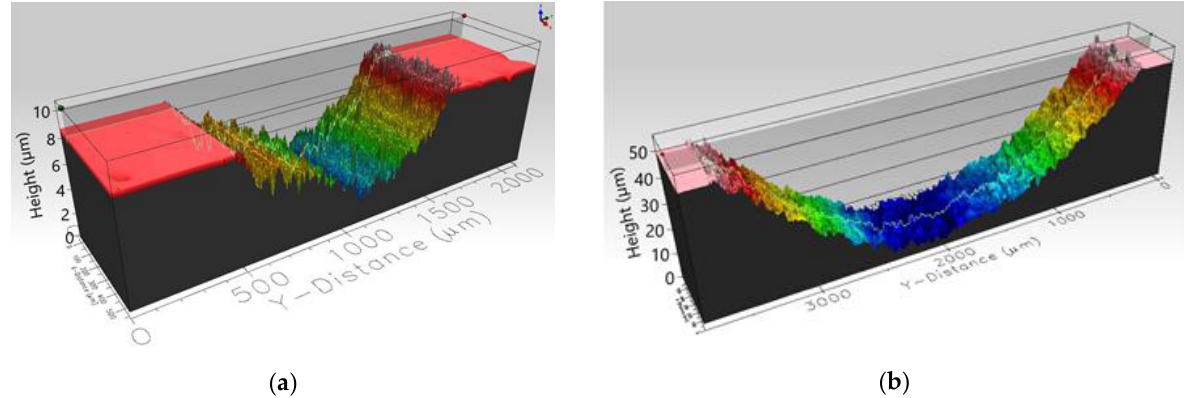
Figure 2. Profilometer characteristics of the worn ATZ sample surface used for volumetric characteristics of the mass loss during the tribological test; collected at 20 °C ( a ) and at 300 °C ( b ).